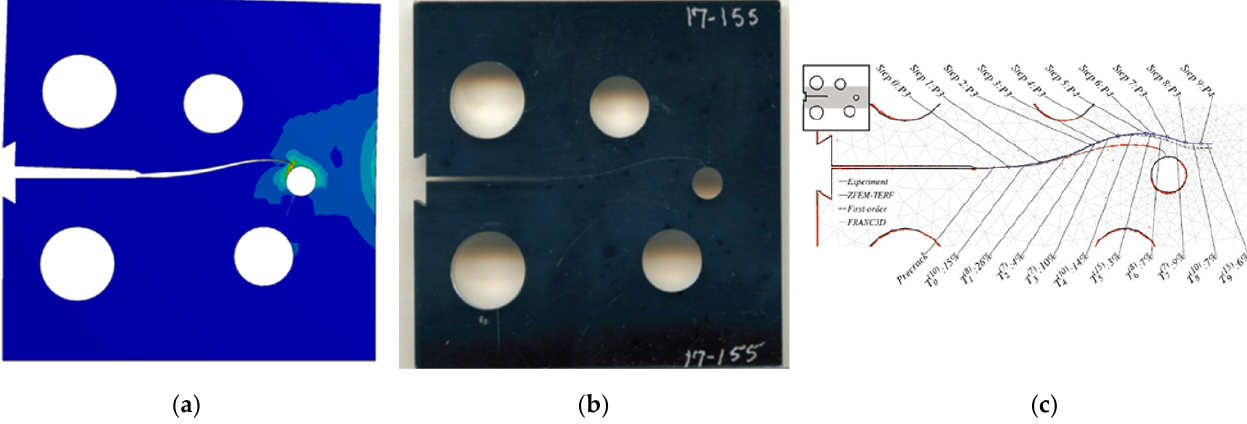
Figure 11. Case 3, predicted crack growth trajectory by ( a ) present study, ( b ) experimental, and ( c ) numerical crack path obtained by [51].